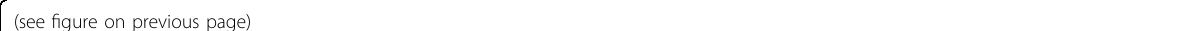
Fig. 3 ZHX2 targeted and negatively regulated linc00707. A Expression levels of linc00707 in glioma tissues. Data are presented as the mean ± SD ( n = 9, each group). * P < 0.05, ** P < 0.01 vs. NBTs group; # P < 0.05 vs. LGGTs group. B Expression levels of linc00707 in glioma cells. Data are presented as the mean ± SD ( n = 3, each group). * P < 0.05, ** P < 0.01 vs. HA group. C – E CCK-8 assay, transwell, and three-dimensional culture were applied to evaluate the proliferation, migration, invasion, and tube formation effect of linc00707 on U87 and U251 cells. Representative images and corresponding statistical plots are shown. The scale bar represents 50 µm. F Protein levels of MMP2, MMP9, and VE-cadherin regulated by linc00707 in U87 and U251 cells. Data are presented as the mean ± SD ( n = 3, each group). * P < 0.05,** P < 0.01 vs. linc00707( − )-NC group. G Schematic representation of linc00707 promoter region in 3000 bp upstream of the transcription start site (TSS; designated as + 1). PCR products for putative linc00707 binding sites and an upstream region not expected to associate with ZHX2 were depicted with bold lines. Dashed lines represent the primers used for each PCR. The image was representative of independent ChIP experiments. H Expression levels of linc00707 regulated by ZHX2 in U87 and U251 cells. Data are presented as the mean ± SD ( n = 3, each group). * P < 0.05, ** P < 0.01 vs. ZHX2( + )-NC group. I RT-qPCR analysis for HNRNPD and ZHX2 regulating linc00707 expression in U87 and U251 cells. Data are presented as the mean ± SD ( n = 3, each group). * P < 0.05, ** P < 0.01 vs. HNRNPD( − )-NC + ZHX2( + )-NC group; # P < 0.05 vs. HNRNPD( − ) + ZHX2( + )-NC group; & P < 0.05 vs. HNRNPD( − )-NC + ZHX2( + )